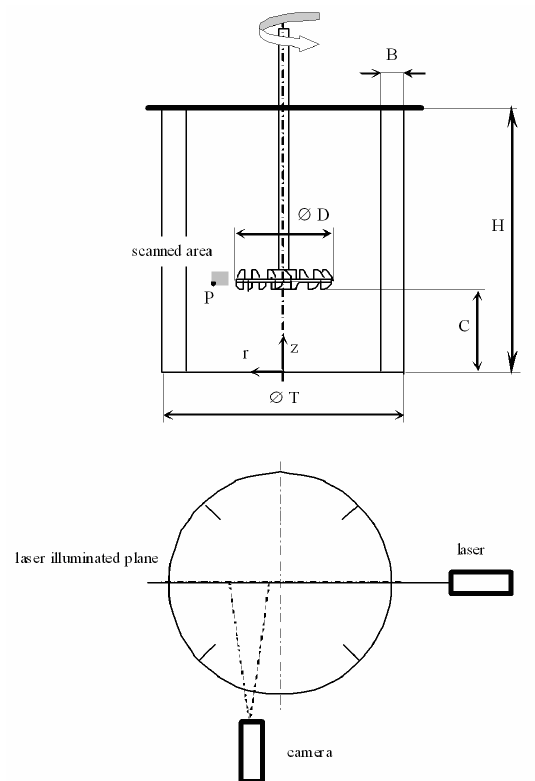
Fig. 1. Scheme of the experimental apparatus and the investigated